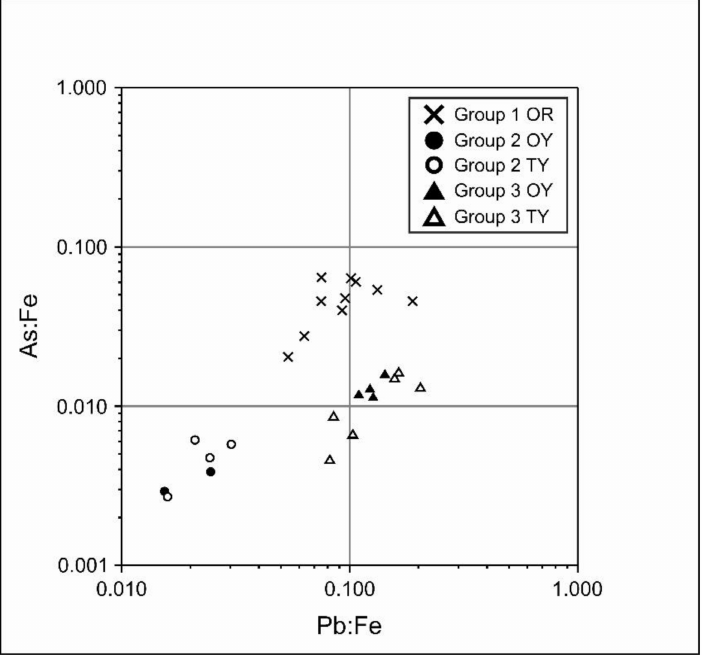
Figure 5. Scatterplot of Pb:Fe vs. As:Fe in the points of the tablinum walls analyzed by p-XRF, calculated from the adjusted peak area